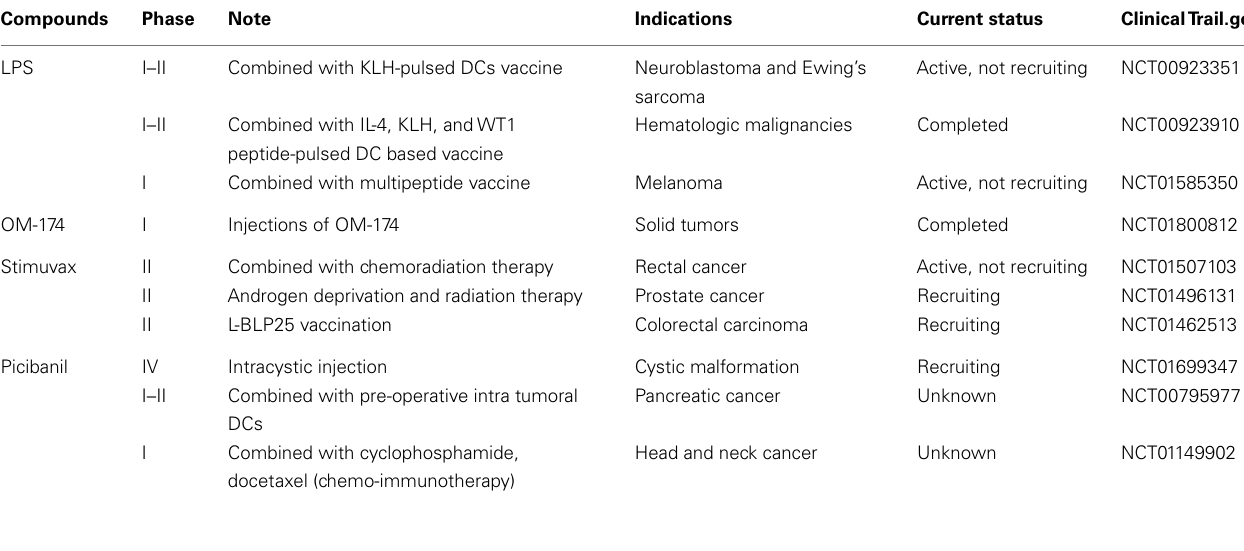
Table 1 |TLR4 agonists in clinical trials